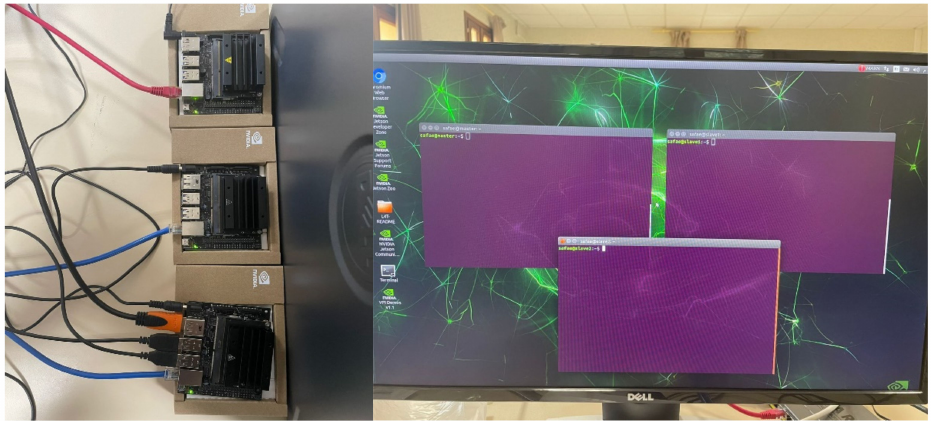
Figure 8. Real-world deployment of SBC